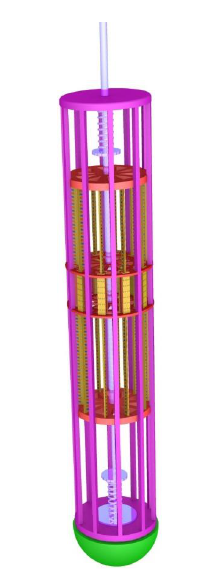
Figure 5. Graphic representation of DEIM Point Absorber.